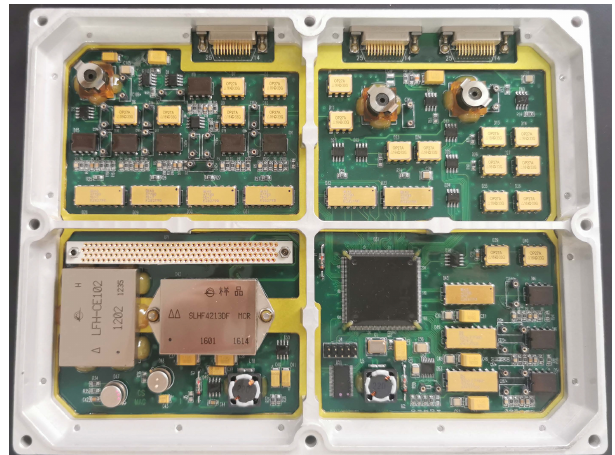
Figure 6. The fluxgate magnetometer electronics placed on a shared